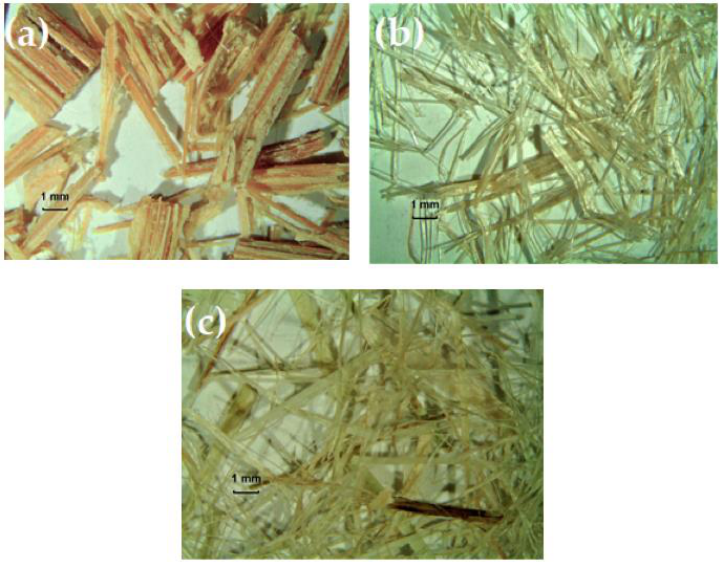
Figure 1. Morphology of the bamboo ( a ), kenaf ( b ) and hemp ( c ) fibers.